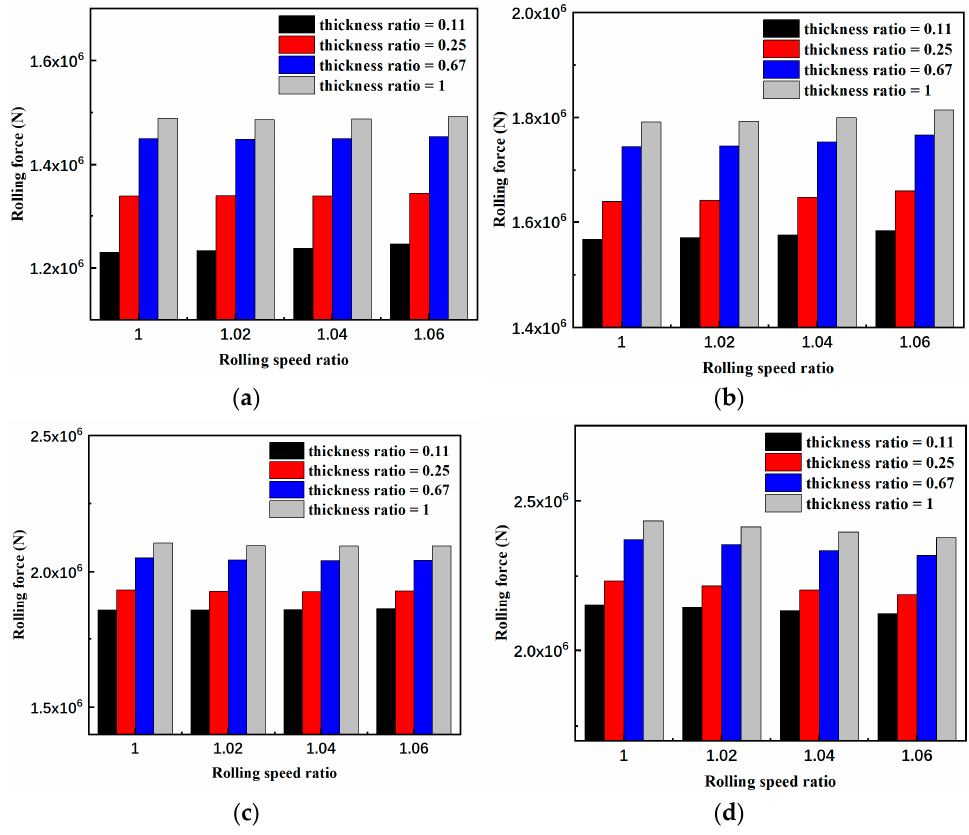
Figure 10. Changes in rolling force vs. rolling speed ratio of the clad plate. ( a ) Reduction ratio = 20%, ( b ) reductio ratio = 30%, ( c ) reductio ratio = 40%, ( d ) reductio ratio = 50%.